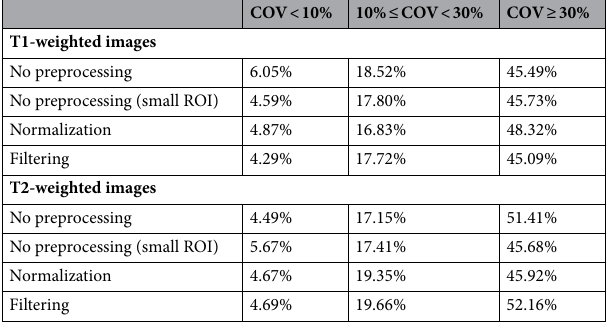
Table 4. Average COV for T1- and T2-weighted images. Small ROI diameter of 1.2 cm, regular ROI diameter of 1.8 cm.